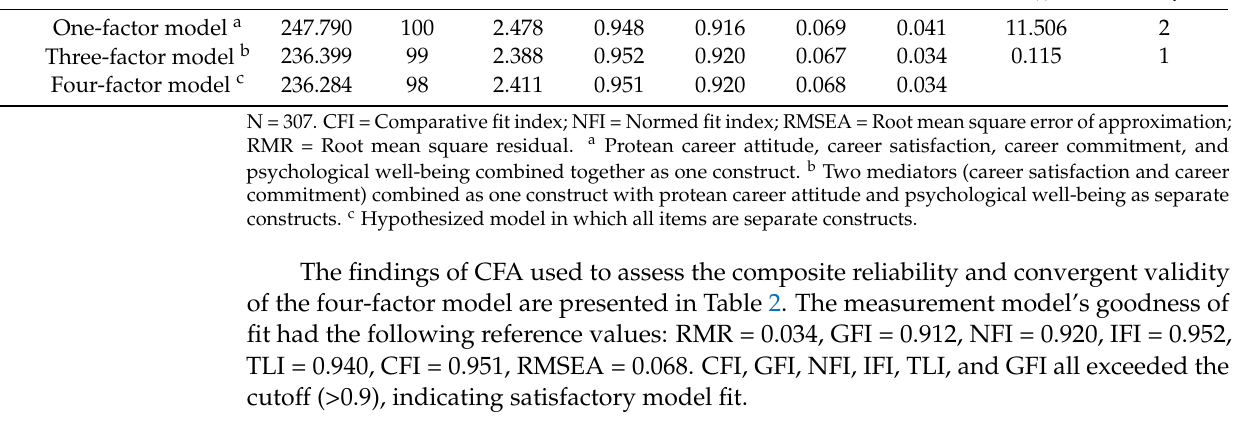
Table 2. Results of the confirmatory factor analysis of the four-factor